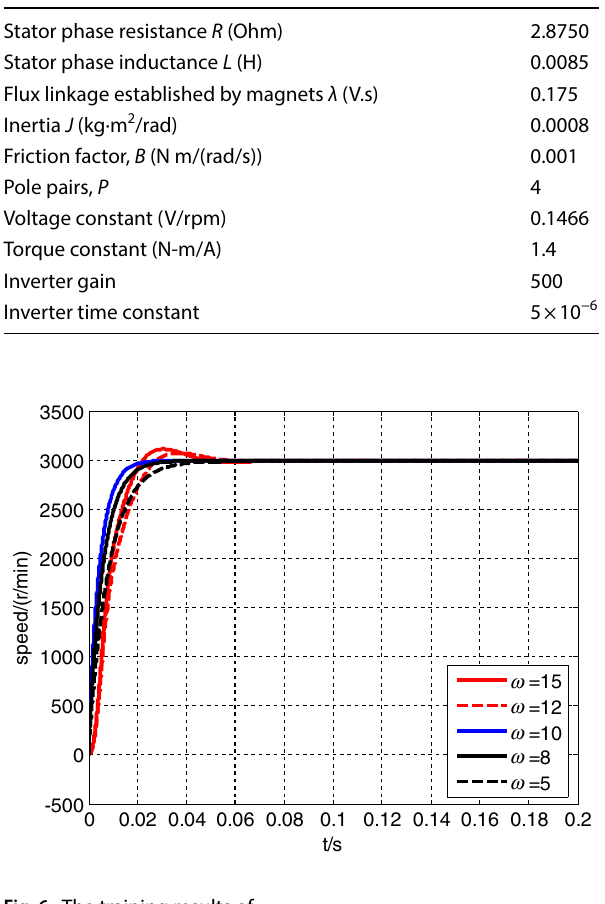
Fig. 6 The training results of